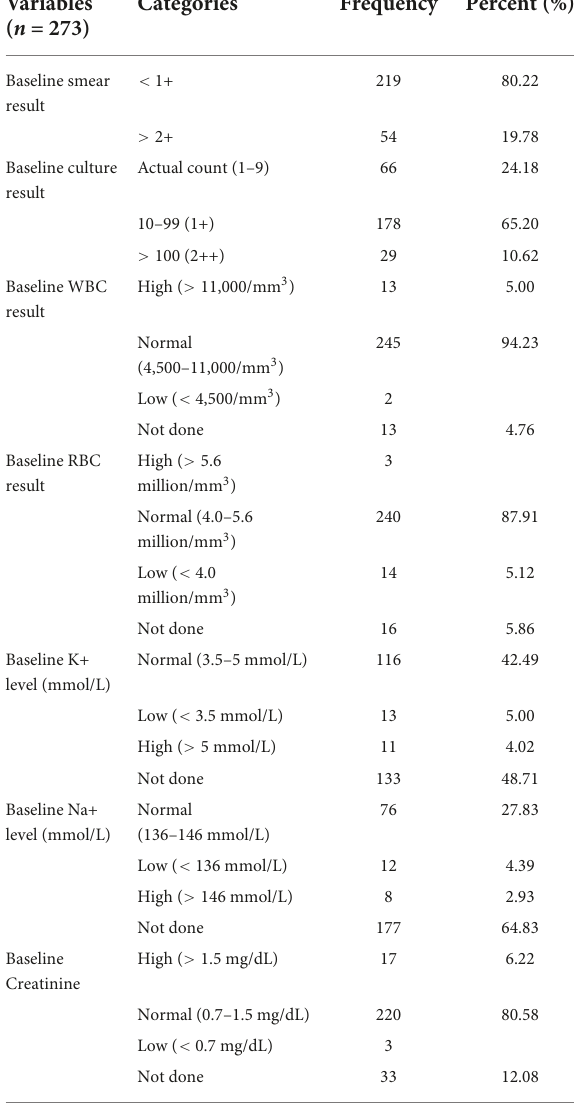
TABLE 3 Baseline microbiological and laboratory test results of DR-TB patients in Harari regional state and Dire Dawa city administration, east Ethiopia, from 2013 to 2021 ( N =